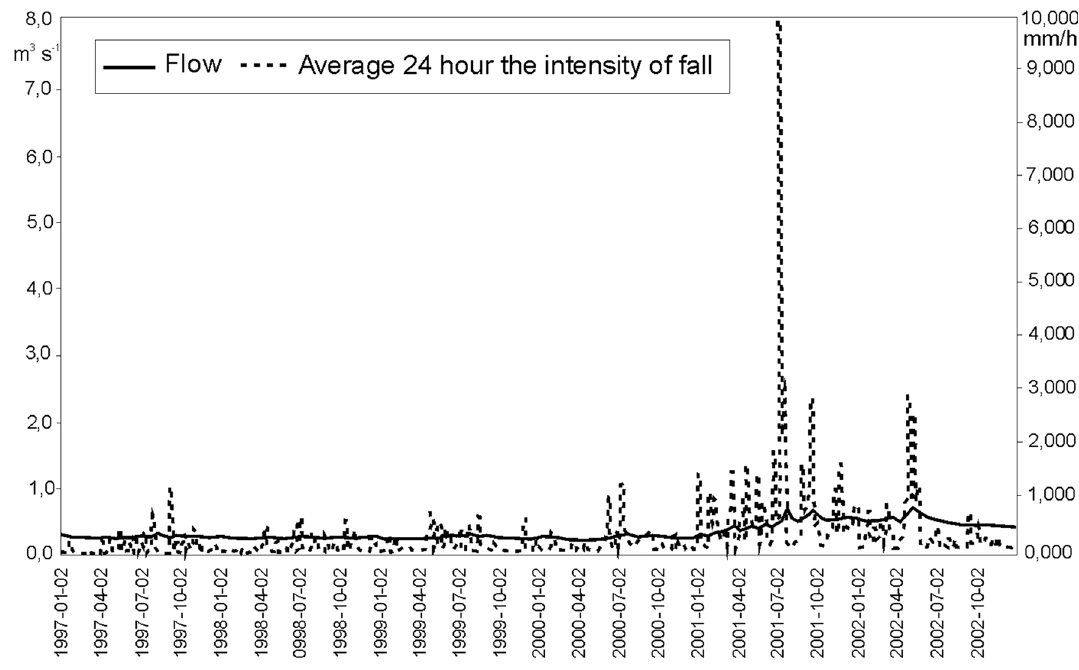
Fig. 10 Relationship between mean daily precipitation intensity and volume of discharges in the outlet section of the Potok Oliwski in balance